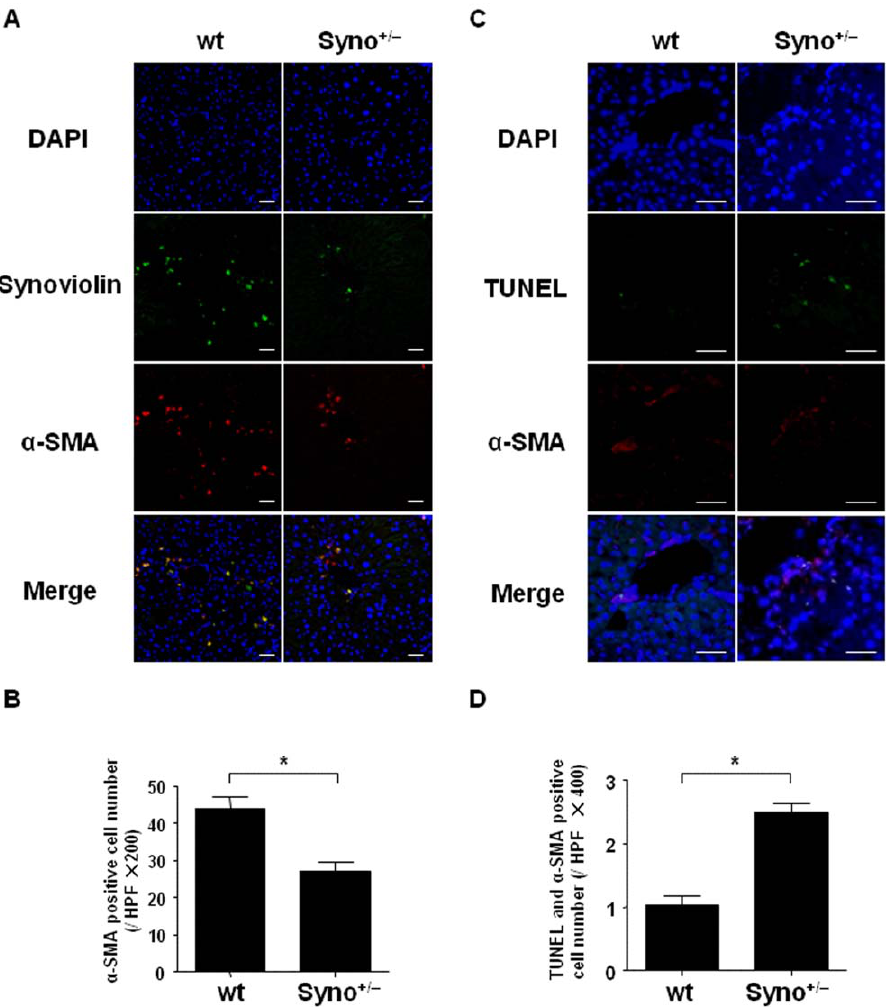
Figure 3. Increase in the number of apoptotic activated hepatic stellate cells in Syno + / 2 mice. (A) Double-labeled fluorescent immunohistochemical analysis of liver sections of wt (n=14) and Syno + / 2 mice (n=12) after treatment with CCl 4 twice a week for 3 weeks. The nuclei were counterstained with DAPI (Vectashield). The expression and localization of synoviolin (green) and a -SMA (red) were analyzed using anti- synoviolin and a -SMA antibodies. Scale bar =100 m m. (B) The analysis of the number of a -SMA-positive cells in liver sections of wt and Syno + / 2 mice after treatment with CCl 4 twice a week for 3 weeks. Data are represented as mean 6 SEM (wt: n=14, Syno + / 2 : n=12 of the CCl 4 -induced chronic hepatic injury model). Unpaired Student’s t -test was used for statistical analysis. * P , 0.01. (C) Double-labeled fluorescent immunohistochemical analysis of liver sections of wt and Syno + / 2 mice after treatment with CCl 4 twice a week for 3 weeks. The nuclei were counterstained with DAPI (Vectashield). The expression and localization of TUNEL (green) and a -SMA (red) were analyzed using an in situ apoptosis assay kit and a -SMA antibodies. Scale bar =100 m m. (D) The analysis of the number of TUNEL and a -SMA double-positive cells in liver sections of wt and Syno + / 2 mice after treatment with